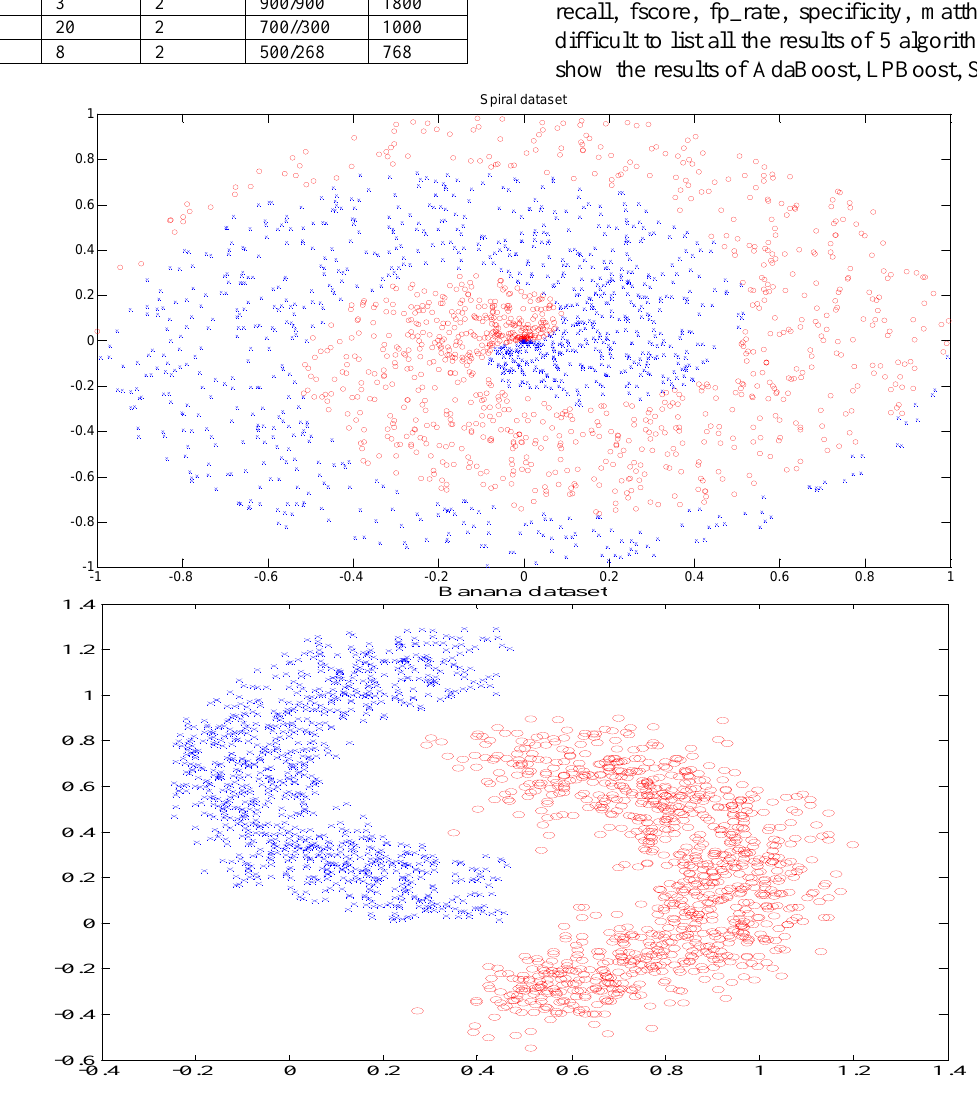
Fig. 3. Dataset of Spiral and